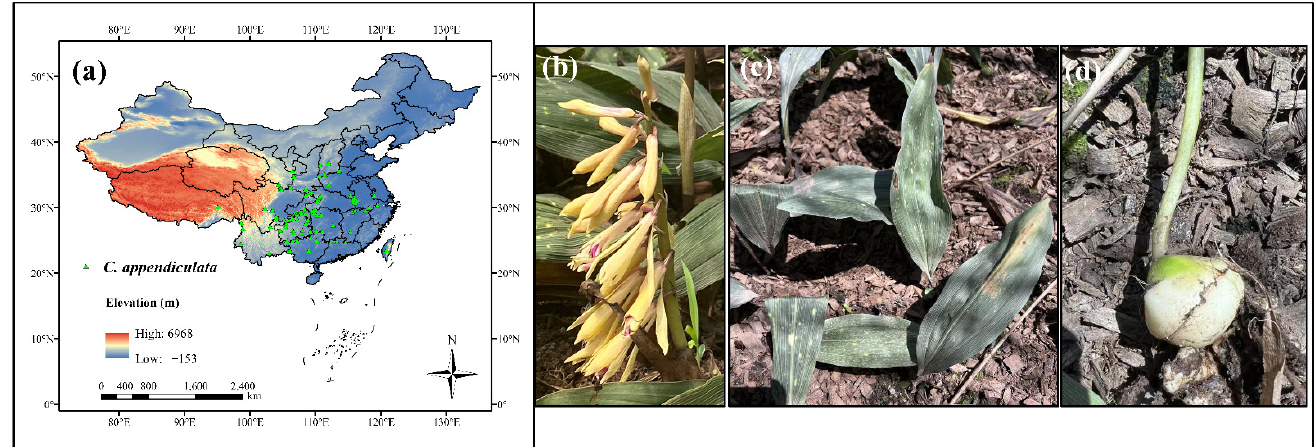
Figure 1. Photos of Cremastra appendiculata in the field and its distribution across China. ( a ) location; ( b ) flower; ( c ) individual; ( d ) pseudobulb.